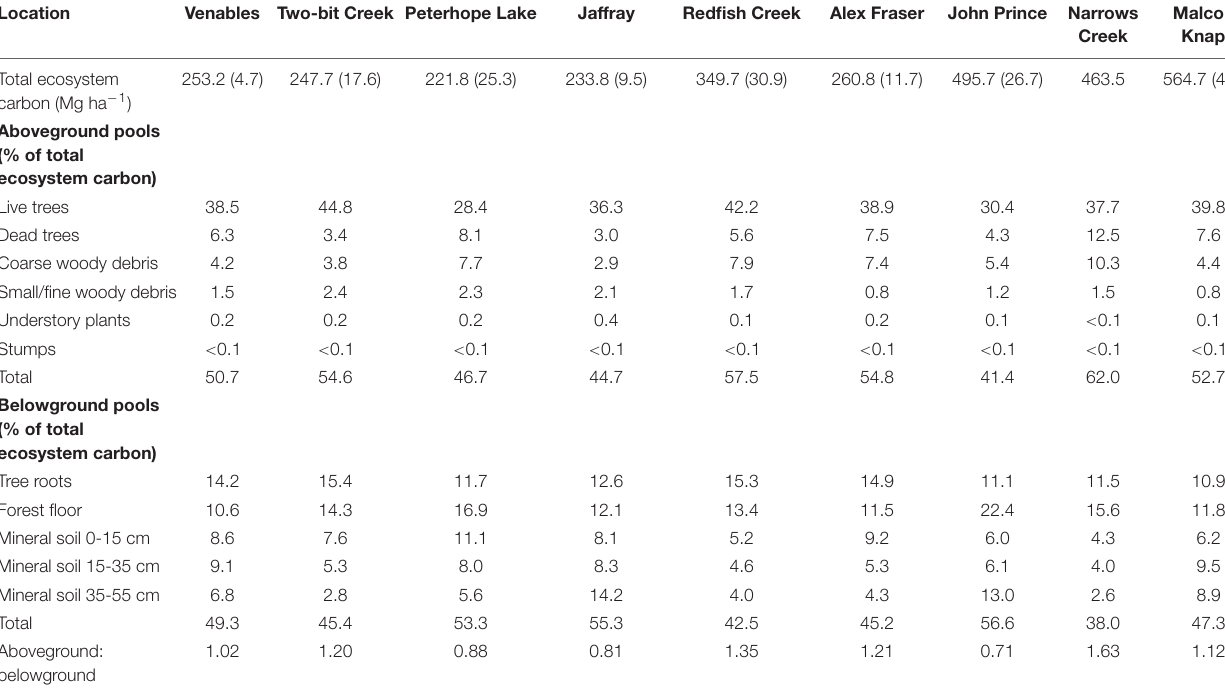
TABLE 2 | Ecosystem carbon, percent carbon by pool, and aboveground to belowground carbon ratio.